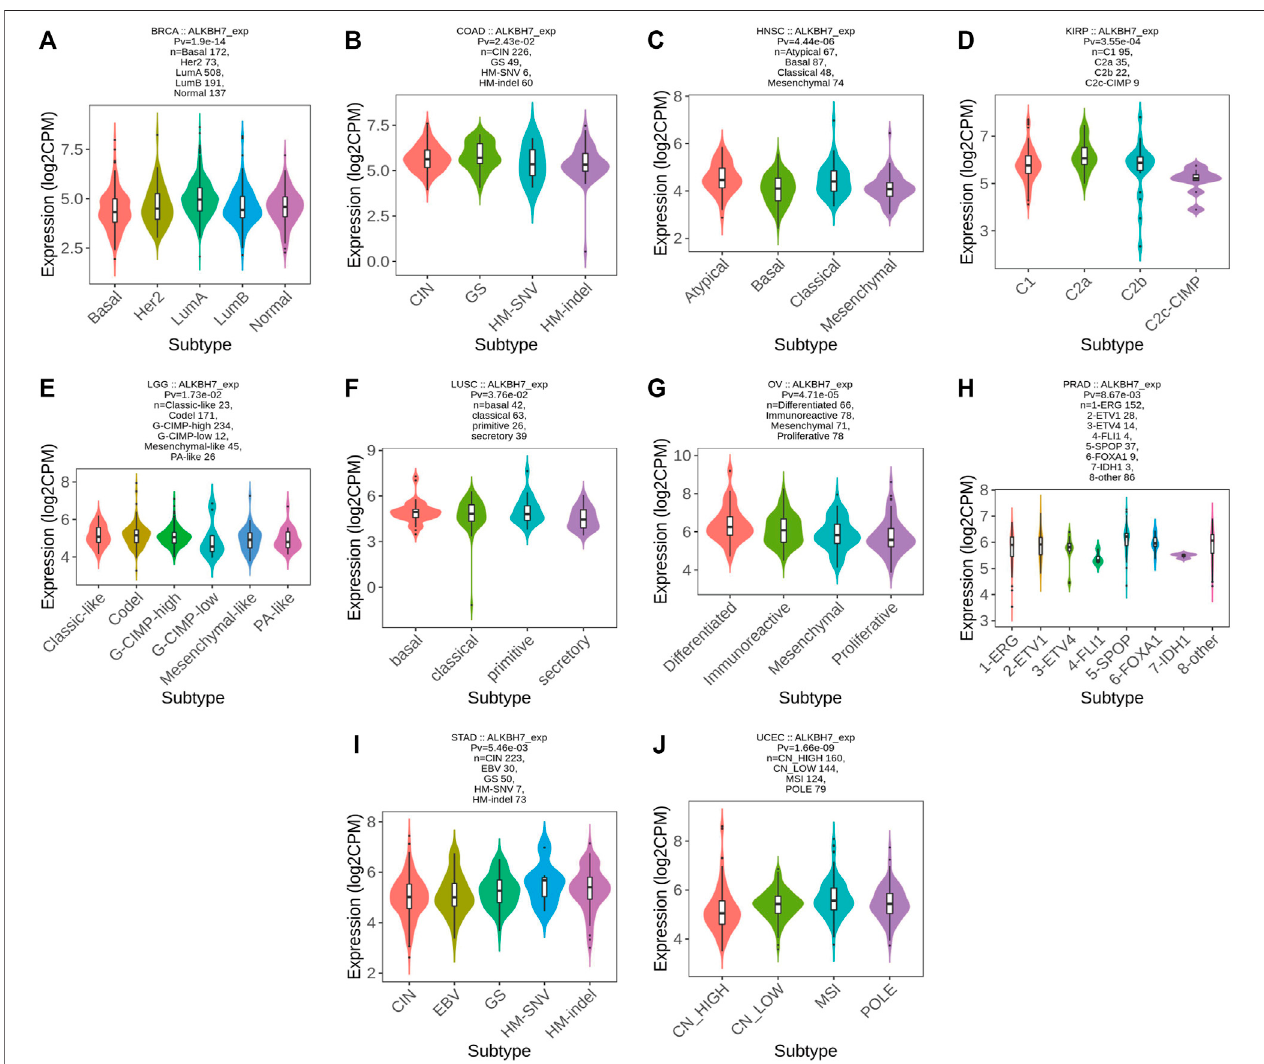
FIGURE 7 | The relationship between ALKBH7 expression and molecular subtypes in BRCA (A) , COAD (B) , HNSC (C) , KIRP (D) , LGG (E) , LUSC (F) , OV (G) , PRAD (H) , STAD (I) and UCEC (J) .